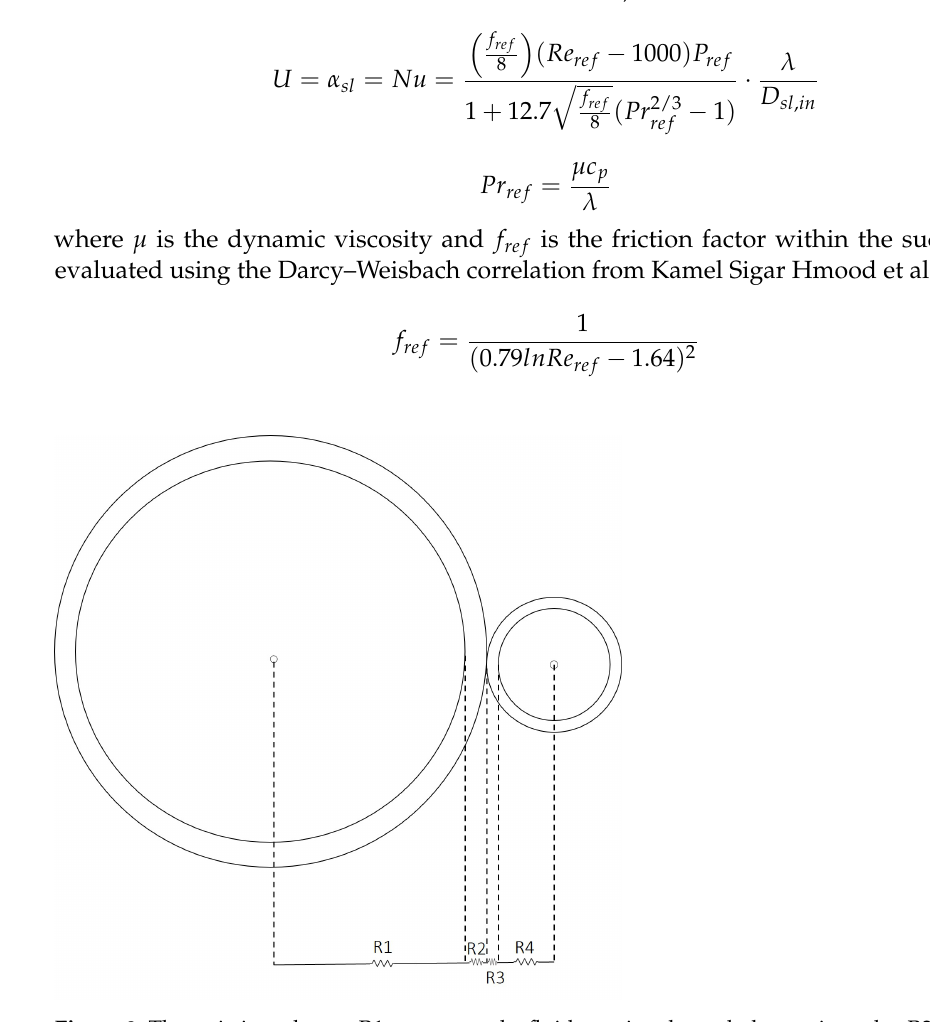
Figure 8. The resistive scheme. R1 represents the fluid running through the suction tube, R2 represents the wall of the suction tube, R3 represents the walls of the capillary tube, and R4 represents the fluid in the capillary